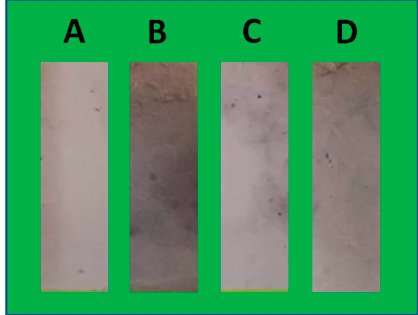
Figure 2. Illustration of the utilized (hot-pressed) scaffolds ( A ) pristine PEI, ( B ) PEI scaffold modified with GNPs, ( C ) PEI scaffold modified with HAP, and ( D ) PEI scaffold modified with GNPs and HAP.